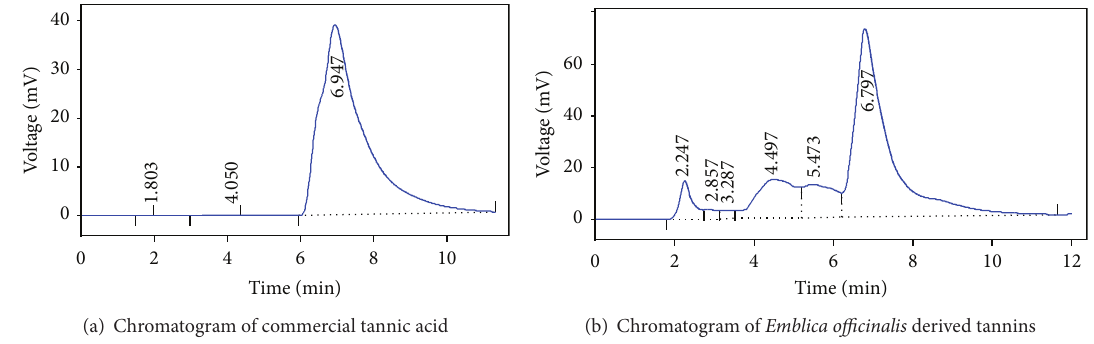
Figure 1: Chromatograms of Emblica officinalis derived and commercial